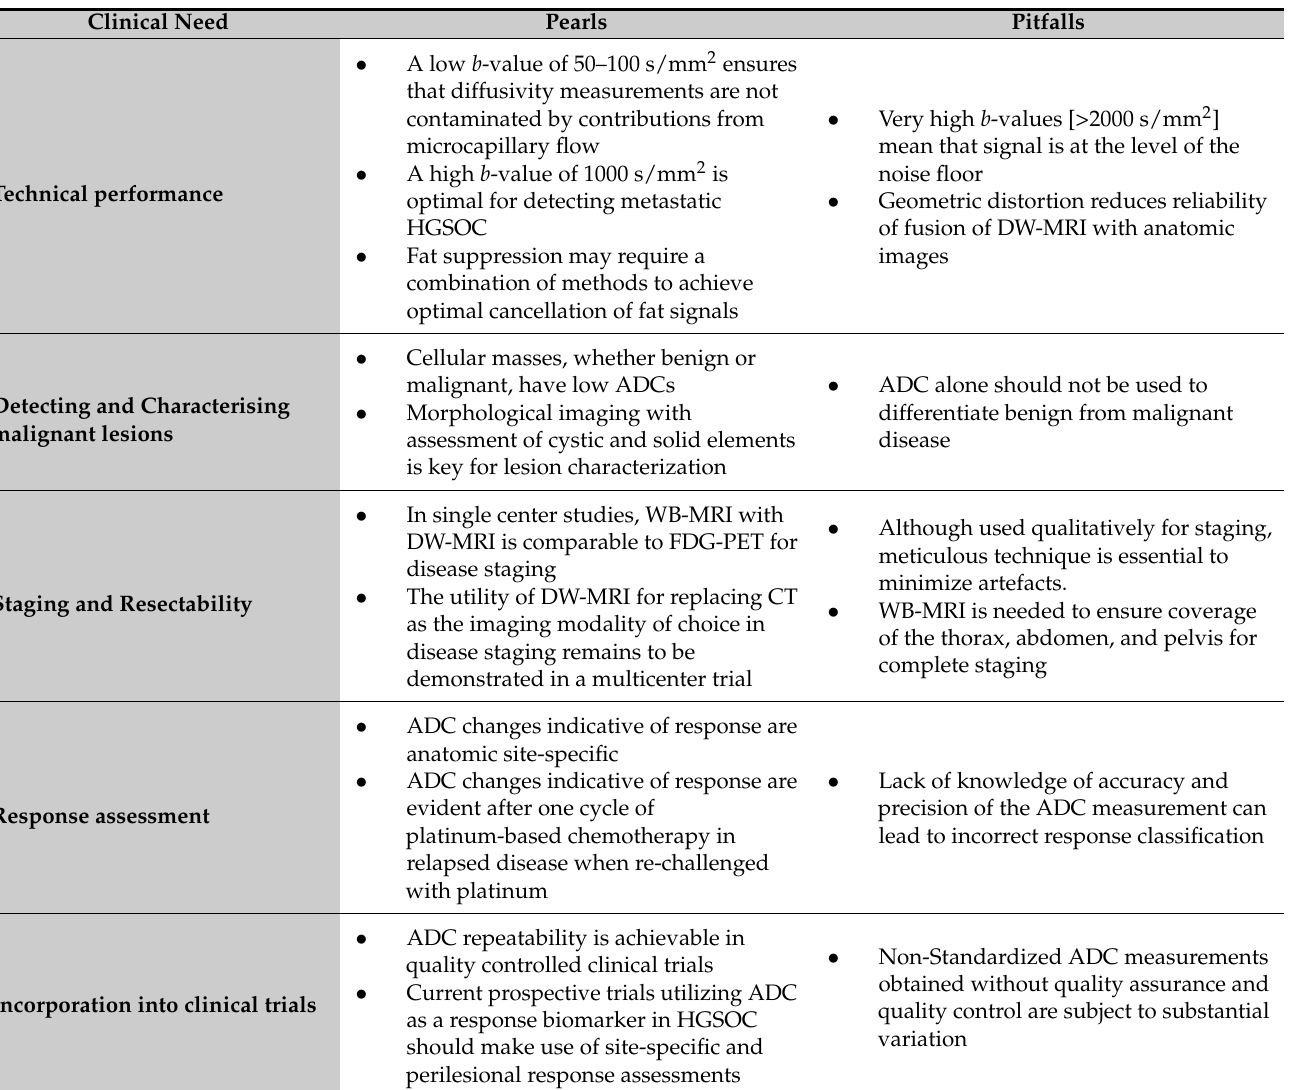
Table 4. Summary of pearls and pitfalls of DW-MRI for imaging high grade serous ovarian